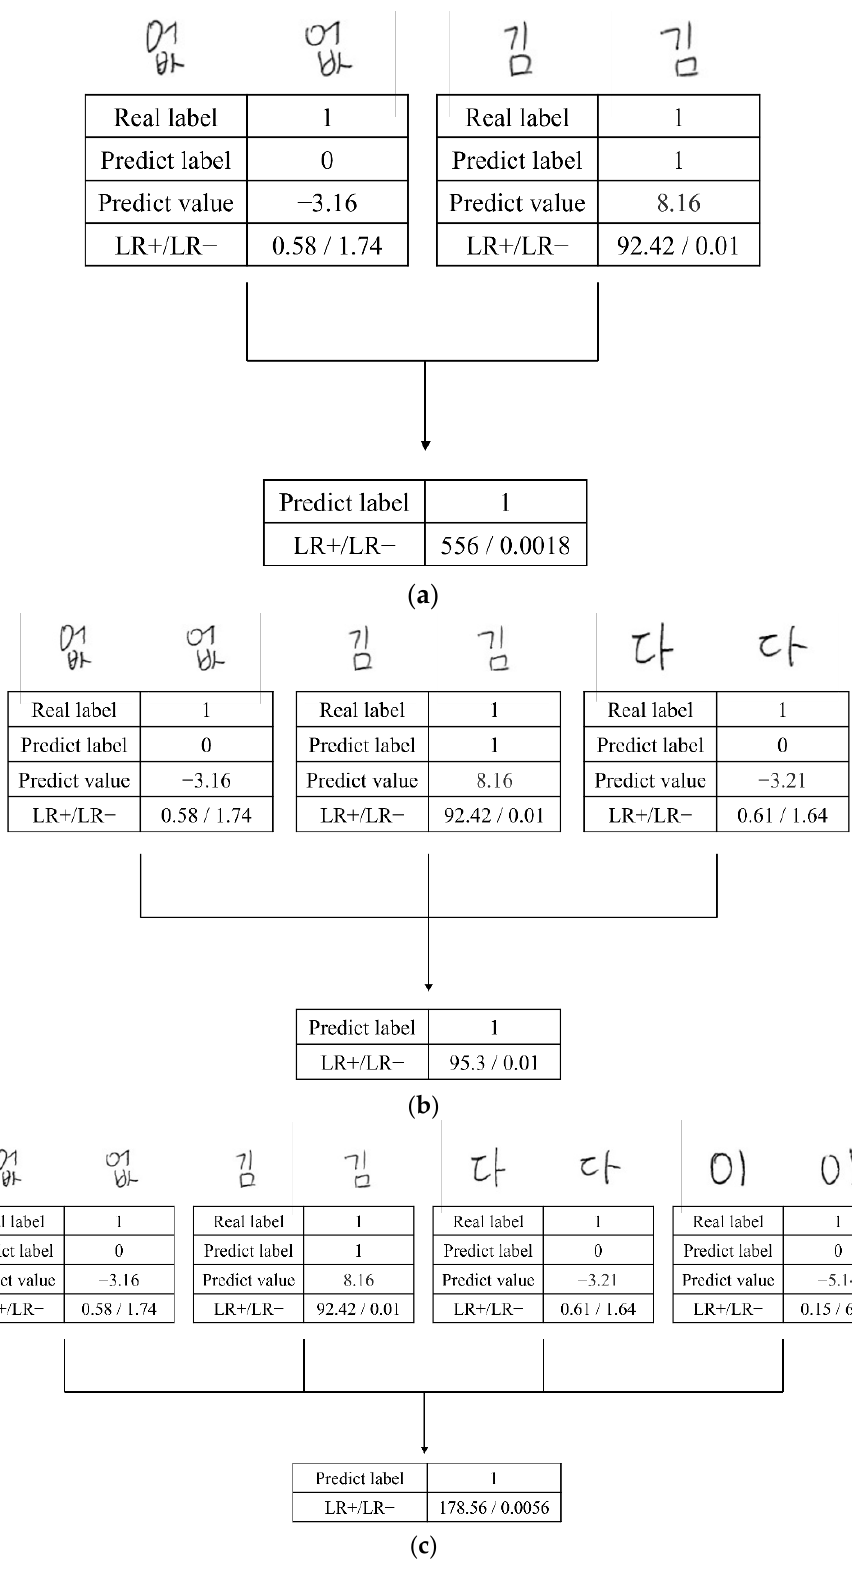
Figure 10. Example of multimodal and likelihood ratio according to the number of combined characters: ( a ) two characters; ( b ) three characters; ( c ) four